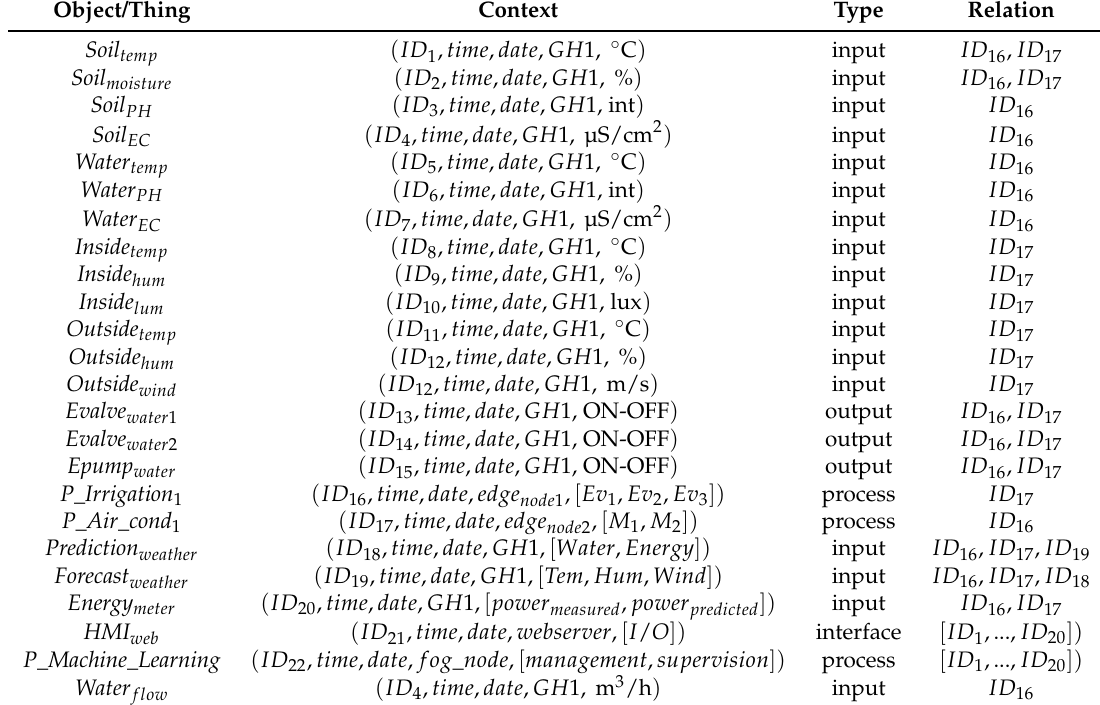
Table 5. Things context identified in experimental greenhouse.